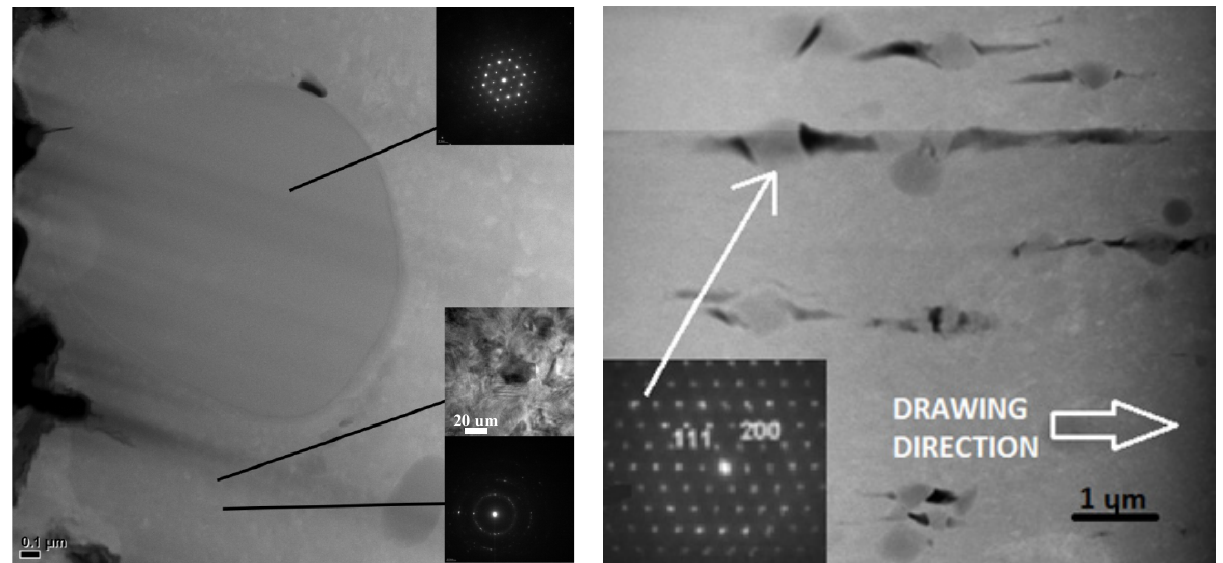
Figure 4: TEM images of the wire after the last heat treatment (1200 s, 400°C).